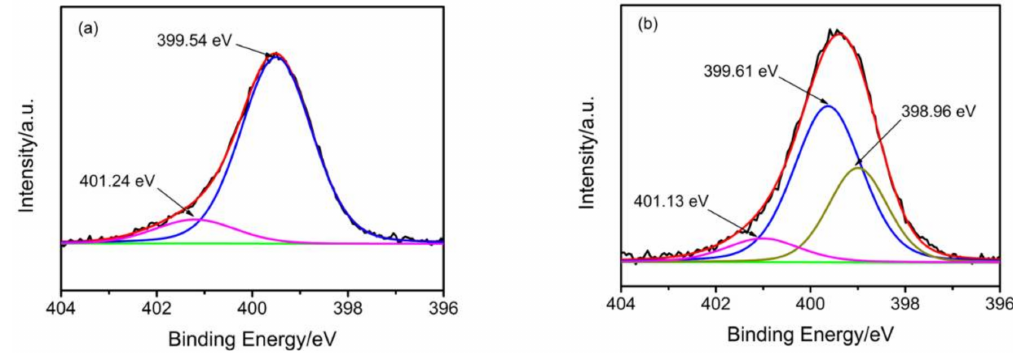
Figure 15. XPS N 1s spectra of g-PAM/OVerm: ( a ) before Pb(II) adsorption and ( b ) after Pb(II)